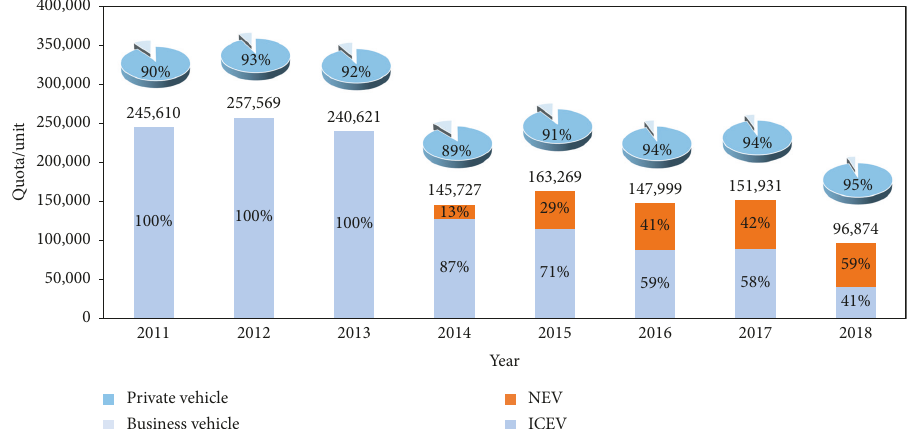
Figure 3: The number of plates issued every year in Beijing under the purchase restriction policies (1: internal combustion engine vehicle (ICEV); 2: new energy vehicle